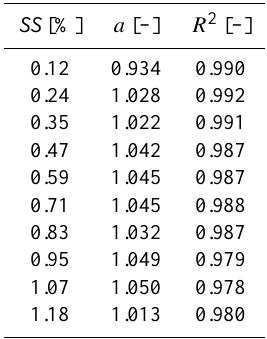
Table 3. Details on the predicted vs. measured CCN number con- centration for the CCN prediction without simplifications. a is the slope of the fitted line, R 2 is the square of the correlation coefficient.